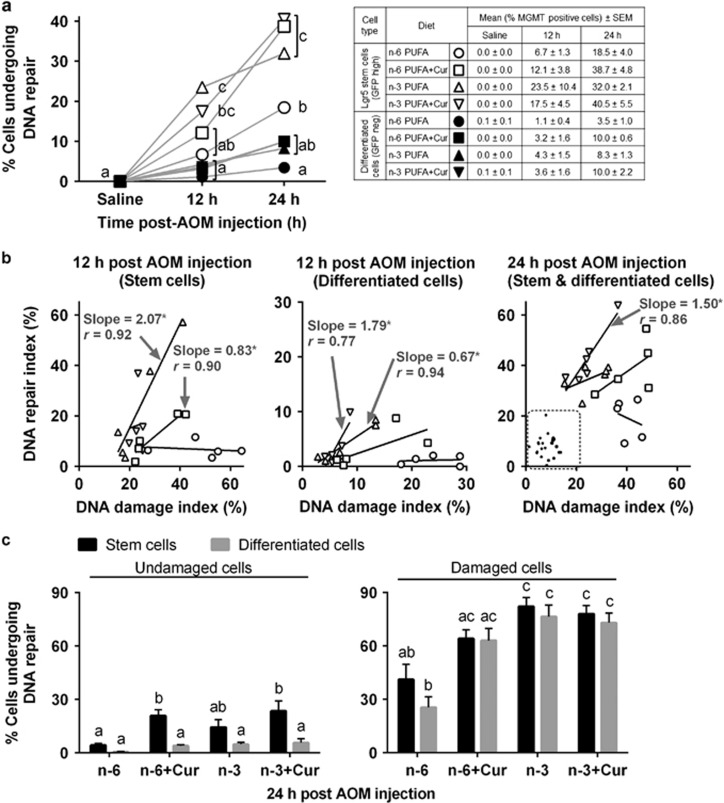
Effect of n-3 PUFA and curcumin on AOM-induced MGMT expression in mouse colonic crypts at 12 and 24 h post AOM injection. (a) Comparison of MGMT+ (DNA damage repairing) stem and differentiated cells in the distal colon of saline and 12 and 24 h post AOM-injected mice (left). GFP+ crypts were scored from n=3 per diet in saline-treated mice; n=5–6 per diet in AOM-injected mice at 12 and 24 h. Refer to Figure 1a legend for statistical details. Different letters indicate significant (P<0.05) differences between treatment groups at each time point. (b) Association between AOM-induced MGMT-expressing cells and γH2AX+ cells in stem and differentiated cells at 12 h (left and middle) and 24 h (right). Each point represents an individual animal and diets are labeled with different symbols as indicated in the table in (a). Slopes shown are found to be significantly different from 0 at a significant level of 0.05. Data from differentiated cells (24 h) are highlighted within the dotted line instead of showing slope because none of the slopes differed from zero. DNA repair index=no. of MGMT+ stem or differentiated cells/total no. of stem or differentiated cells per crypt x100 at 12 and 24 h post AOM injection; damage index=no. of γH2AX+ stem or differentiated cells/total no. of stem or differentiated cells per crypt x100 at 12 and 24 h post AOM injection. Refer to Figure 2b legend for statistical details. (c) Percentage of undamaged cells expressing MGMT (no. of MGMT+ and γH2AX− stem or differentiated cells/total no. of γH2AX− stem or differentiated cells x100) at 24 h post AOM injection (left). Percentage of cells expressing MGMT in damaged cells (no. of double-positive MGMT+ and γH2AX+ stem or differentiated cells/total no. of γH2AX+ stem or differentiated cells x100) at 24 h post AOM injection (right). Refer to Figure 1a legend for statistical details. Bars that do not share the same letter are significantly different (P<0.05). n-6, n-6 PUFA; n-6+Cur, n-6 PUFA+curcumin; n-3, n-3 PUFA; n-3+Cur, n-3 PUFA+curcumin